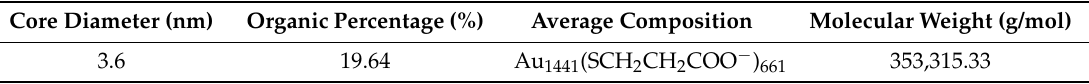
Figure 2. Characterization of synthesized MPA-AuNPs: ( a ) transmission electron microscopy (TEM) micrograph of MPA-AuNPs along with the corresponding size histogram; ( b ) UV-Vis spectrum of MPA-AuNPs; and, ( c ) thermogravimetric analysis (TGA) analysis of MPA-AuNPs. Table 1. Composition of MPA-AuNPs calculated from TEM and TGA.